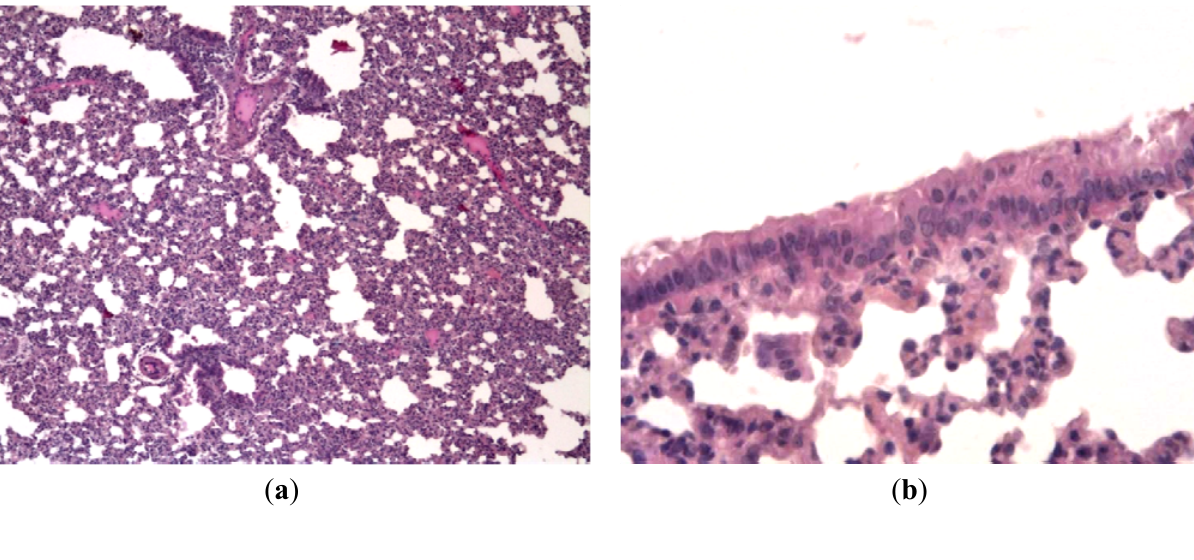
Figure 5. Structure of lung tissue of Syrian hamsters on day 7 after inoculation with hPIV-3 with ( c , d ) or without ( a , b ) treatment with Ingavirin. a , с —Alveoli, b , d